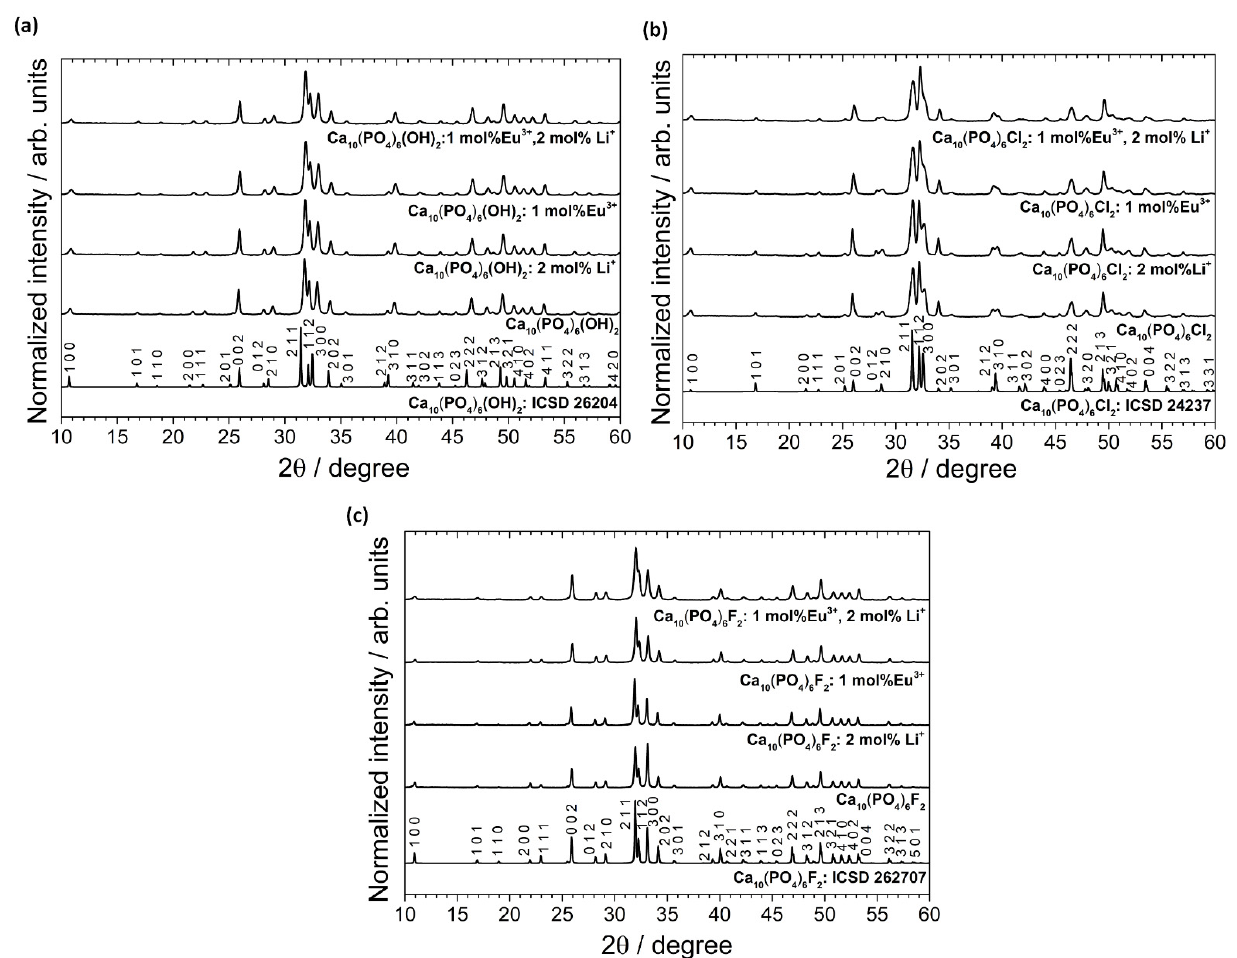
Figure 2. XRPD patterns (with the indication of crystal planes) of the Ca 10 (PO 4 ) 6 (OH) 2 ( a ), Ca 10 (PO 4 ) 6 Cl 2 ( b ), Ca 10 (PO 4 ) 6 F 2 ( c ) un-doped as well as doped and co-doped with 1 mol% Eu 3+ and 2 mol% Li + ions, prepared at 500 °C.